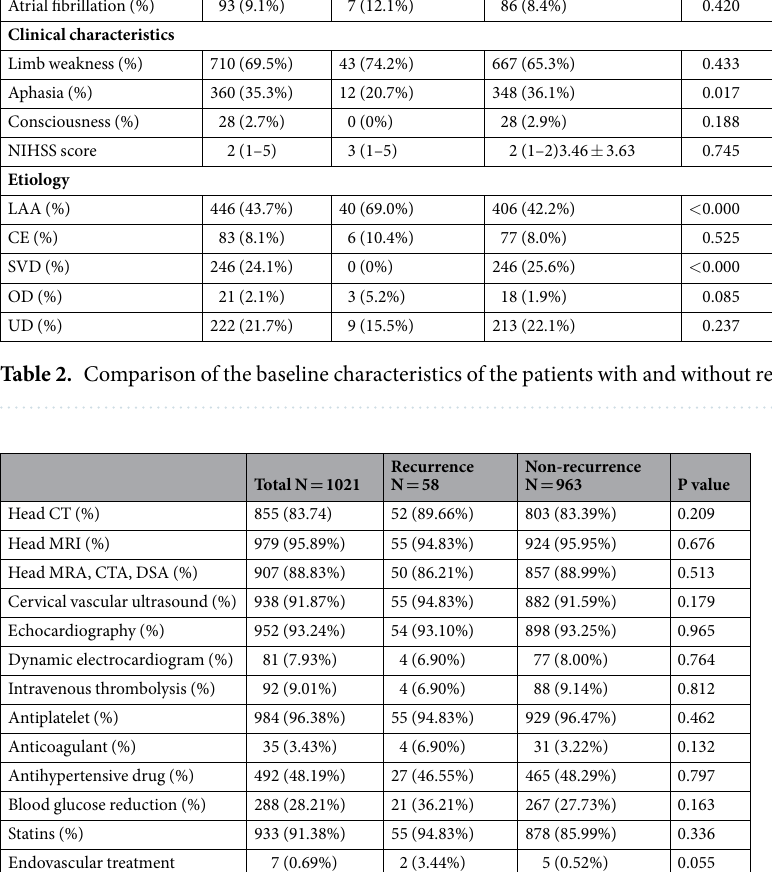
underwent endovascular treatment. The diagnosis and treatment measures for the patients with recurrence and non-recurrence were not significantly different. Comparison of the tested indicators and relevant blood pressure during the hospitalization between the two groups. As shown in Table 4, the values of homocysteine, ultra-sensitivity C-reactive protein, total cholesterol, triglycerides, low-density lipoprotein, high-density lipoprotein, the ratio of low density lipoprotein and high-density lipoprotein, and the blood pressure variation coefficient were not significantly dif- ferent between the two groups of patients. However, the values of fasting blood glucose, glycated hemoglobin, the